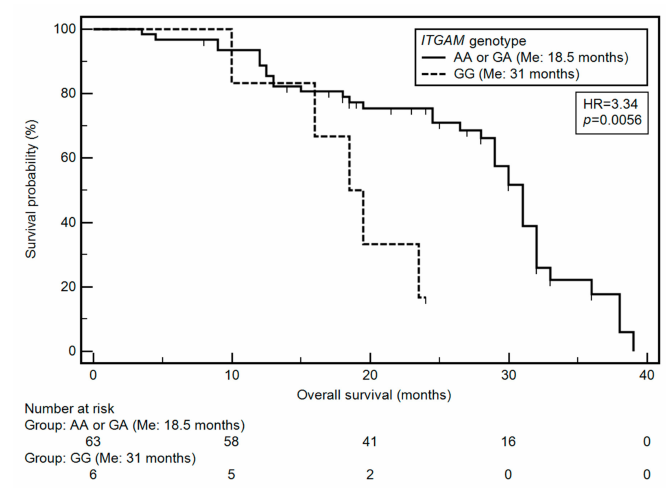
Figure 1. Impact of ITGAM on patients’ overall survival: di ff erences in overall survival between groups of patients with GG and AA or GA genotype. Table 5. Factors a ff ecting overall